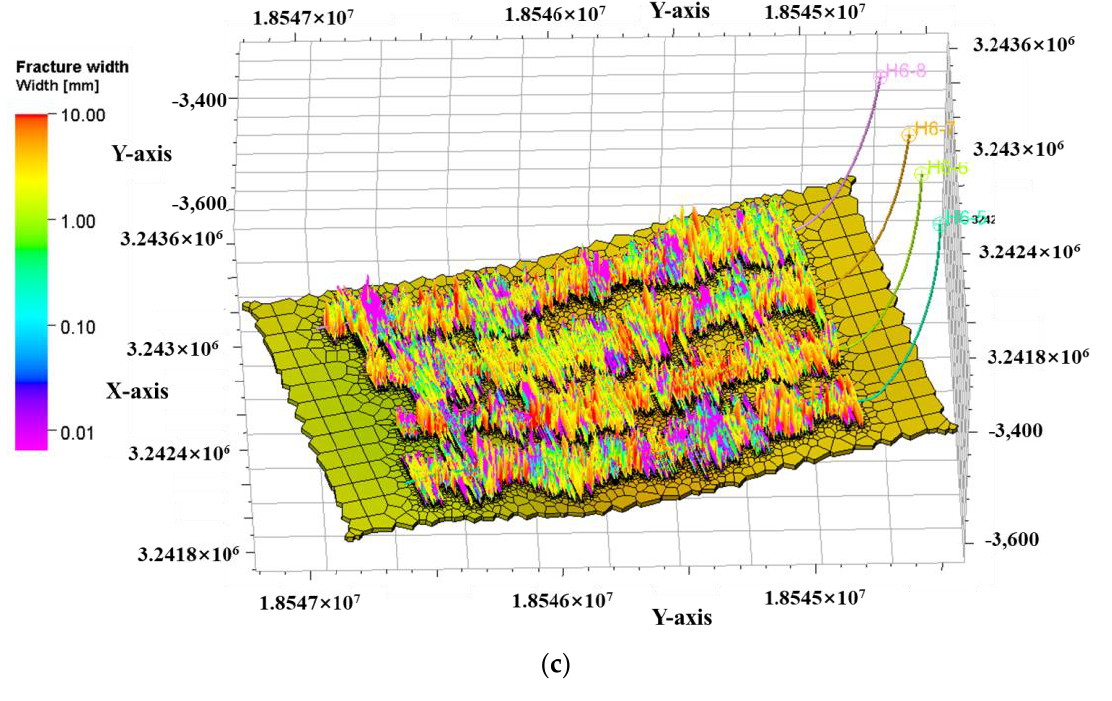
Figure 2. The result of grid division on the platform: ( a ) Hydraulic fracture distribution on the platform; ( b ) Matrix attribute model; ( c ) Unstructured network model of coupled hydraulic fractures.